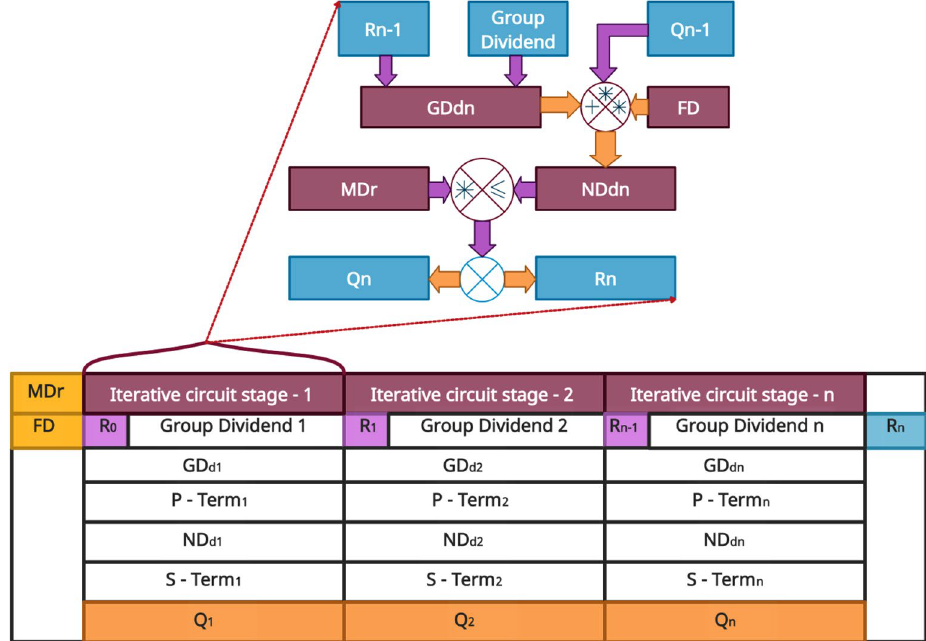
Figure 5. The Awadhoot